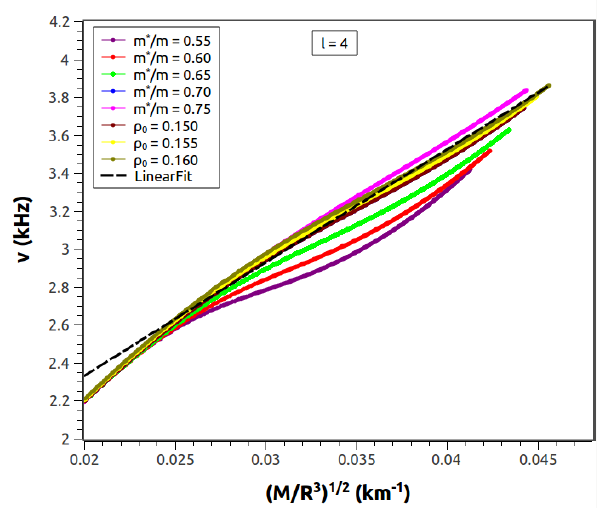
Figure 11. Same as Figure 9 but for higher-order l = 4